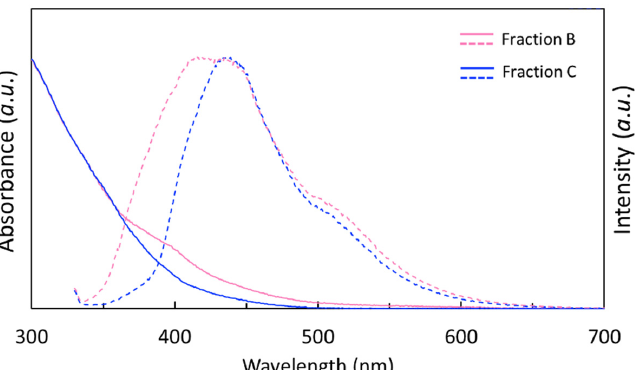
Figure 5. UV/vis absorption and fluorescence spectra of Fraction B [C 60 ( n C 3 H 7 ) 22 ] (pink) and Fraction C [C 60 ( n C 3 H 7 ) 20 ] (blue). The solid and dashed lines are the UV/vis absorption and fluorescence spectra of each fraction in n -hexane, respectively.